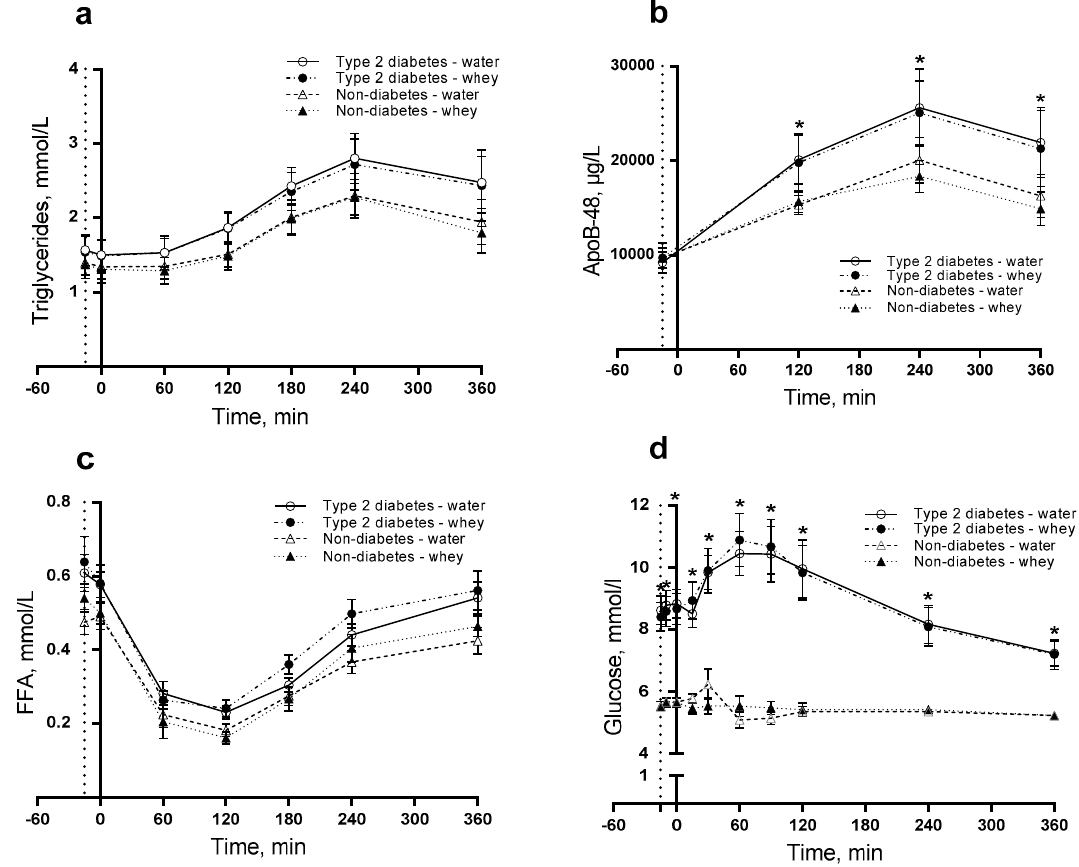
Figure 1. Postprandial responses of triglycerides (TG) ( a ); ApoB-48 ( b ); non-esterified fatty acids (NEFA) ( c ) and glucose ( d ). 12 T2D and 12 non-diabetic subjects were observed after consumption of 20 g whey proteins (WP) or water as a pre-meal ingested 15 min prior to a fat-rich meal. Dotted vertical line (y = − 15) indicates pre-meal consumption. Data are given as mean ± standard error of the mean (SEM), n = 24. * indicates differences between subjects with and without type 2 diabetes. ANOVA for repeated measurements was used to examine the effect of diabetes, intervention and time on the postprandial responses.